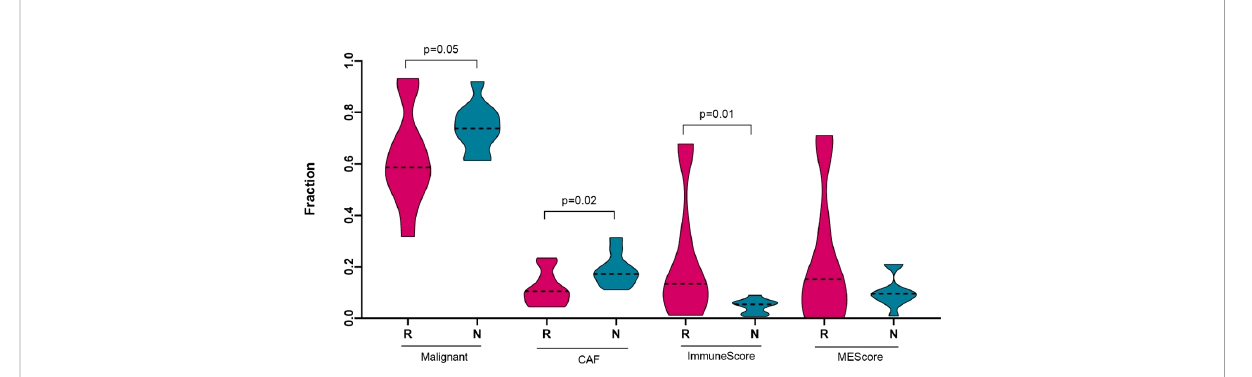
FIGURE 3 Deconvolution study for malignant cells, cancer associated fi broblasts and immune score between responding (n = 10) and non-responding (n = 10) melanomas. Signi fi cance tests were performed using Mann – Whitney U test. On the horizontal axis, R, responder; N, non-responder; CAF, cancer associated fi broblast; and MEScore, micro-environment